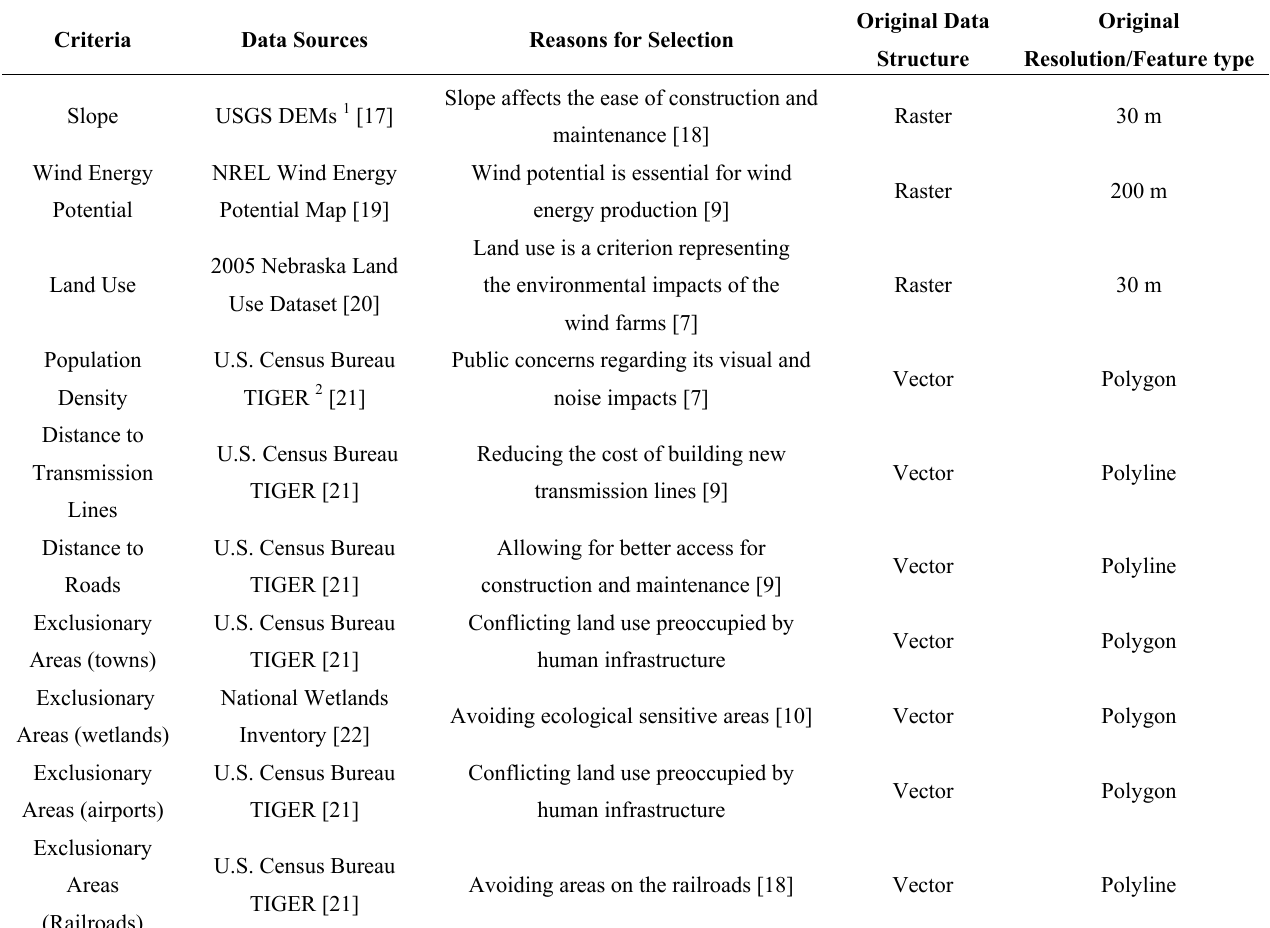
Table 2. Criteria and data sources used to model wind farm